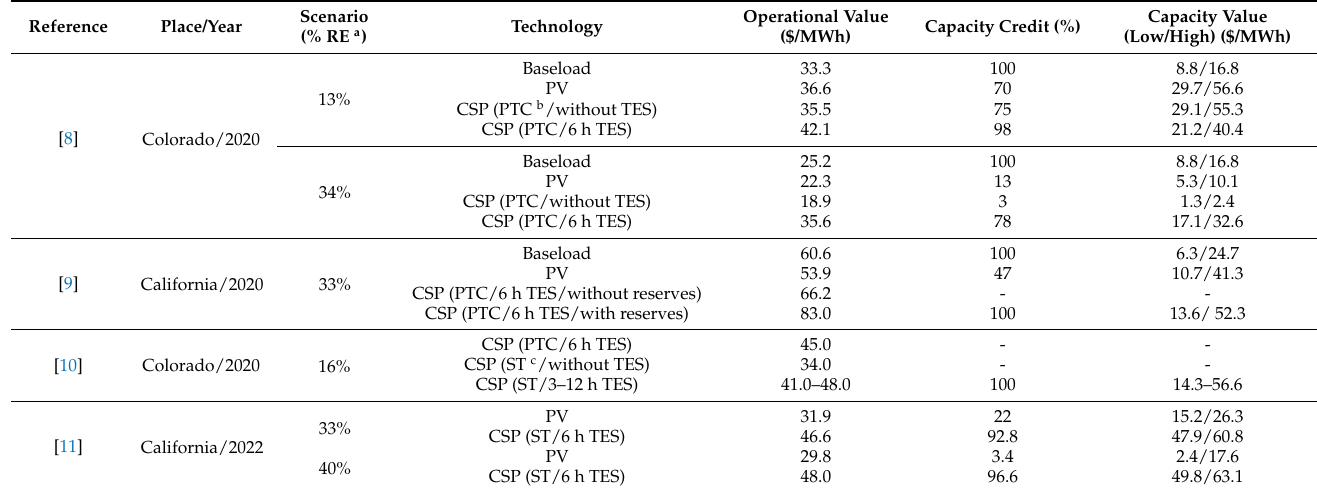
Table 1. Operational and capacity values of CSP plants in thermal